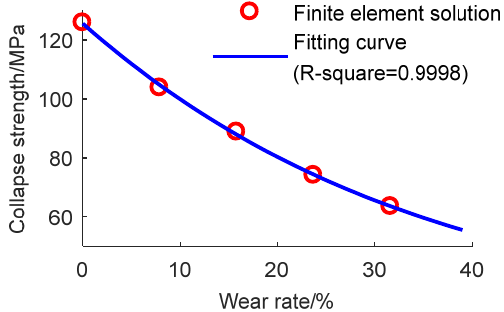
Figure 6. The finite element calculation results and fitting curve.